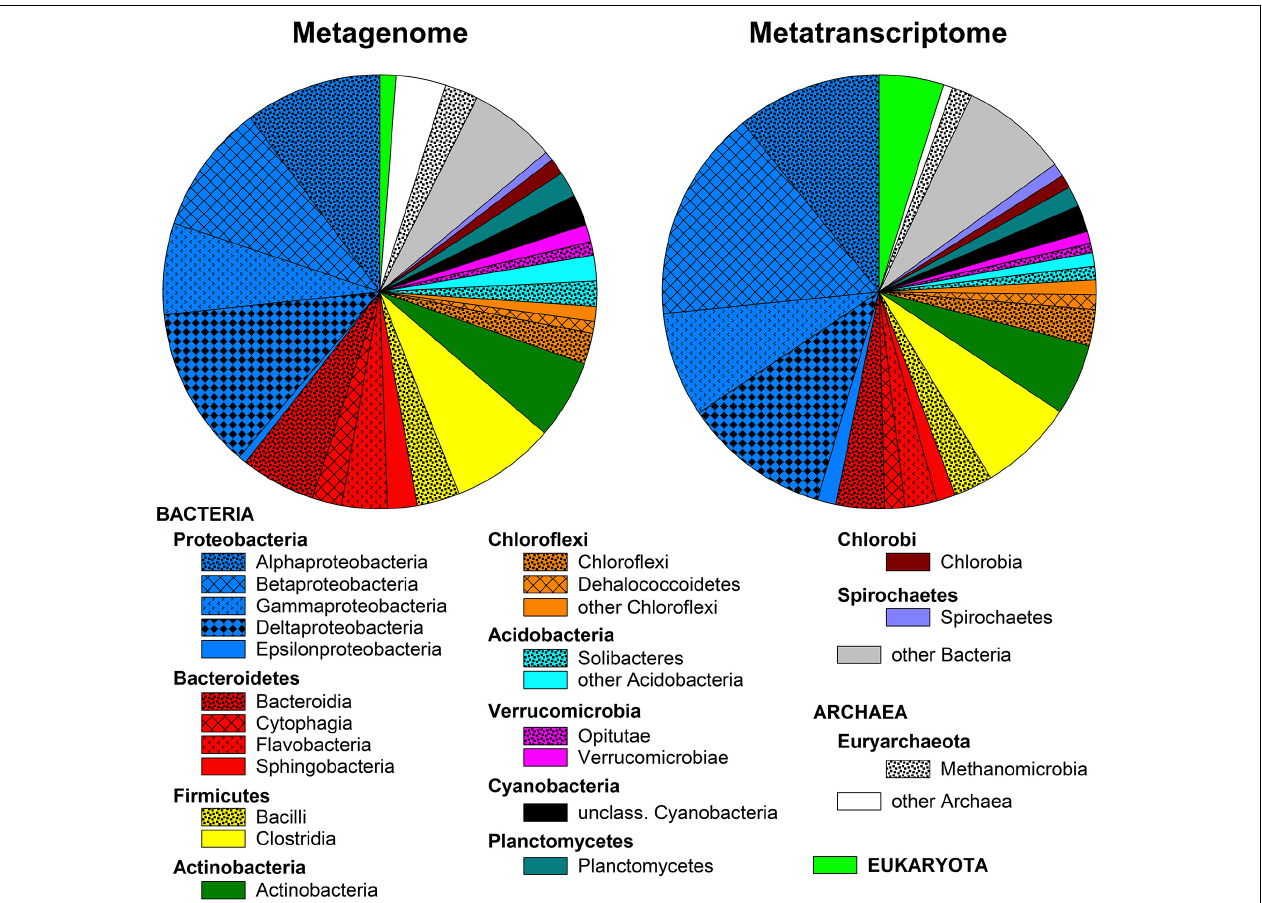
FIGURE 1 | Class-level diversity of the microbial community in surface layer peat soil based on annotation of metagenomic and metatranscriptomic reads against the RefSeq database in MG-Rast. Only classes with a relative abundance > 1% are presented.